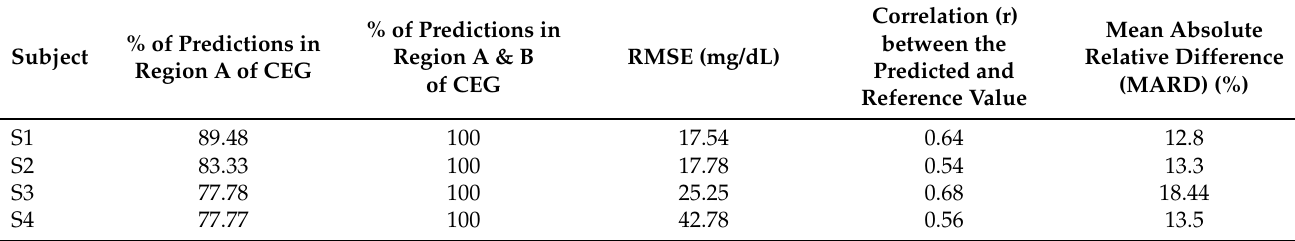
Table 5. Predictions of the blood glucose